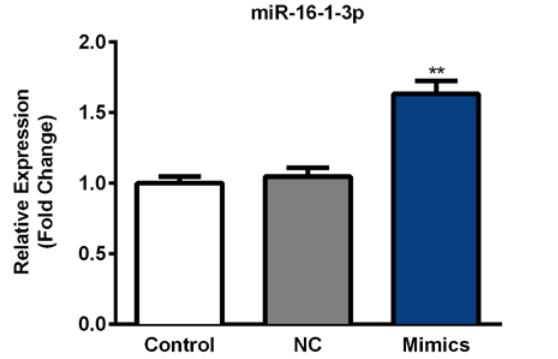
Figure 6: Transfection efficiency of miR-16-1-3p mimic in SMMC-7721 cells.